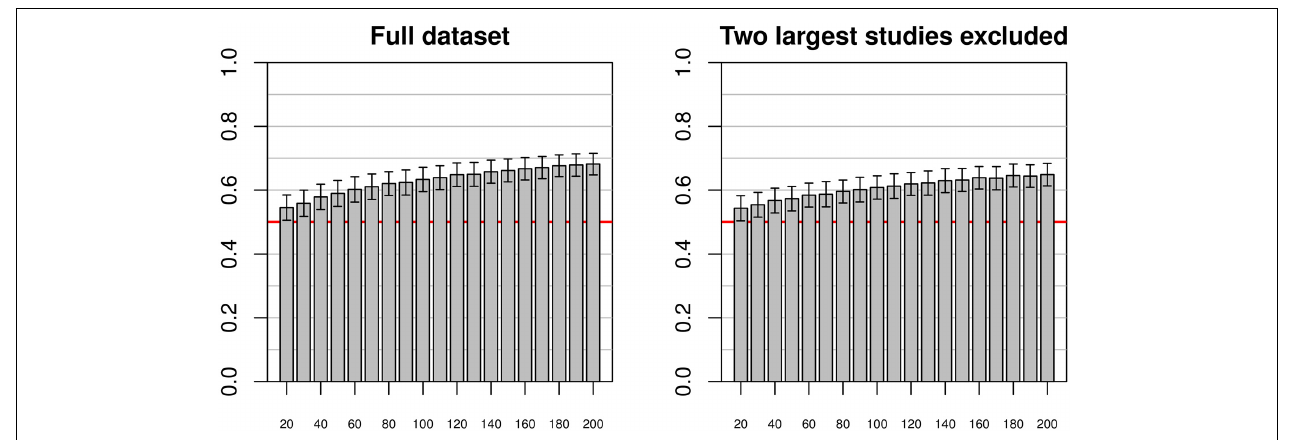
FIGURE 6 | Simulations using test and training datasets from the pooled sample of all studies (left) and a pooled sample of all but the two largest studies (right) using varying training sample sizes between 20 and 200, and a constant test sample size of 200. As with the previous figures, bars